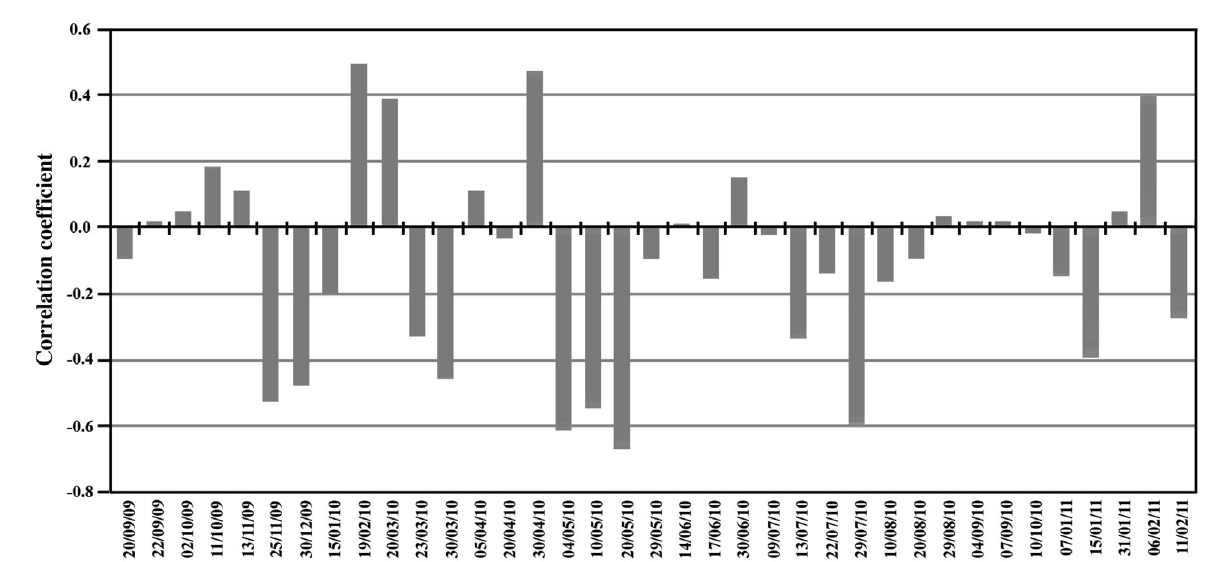
Fig. 8. Correlation coefficients of total suspended matter (TSM) versus Secchi disk depth (SDD) of the entire bay on individual sampling